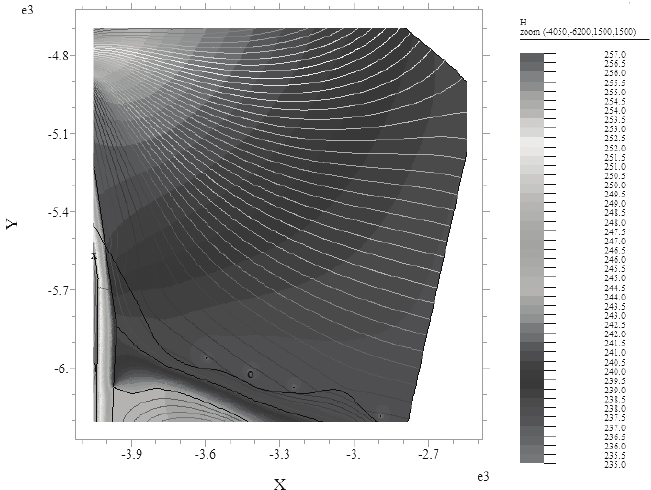
Fig. 10. Map of hydraulic head and streamlines